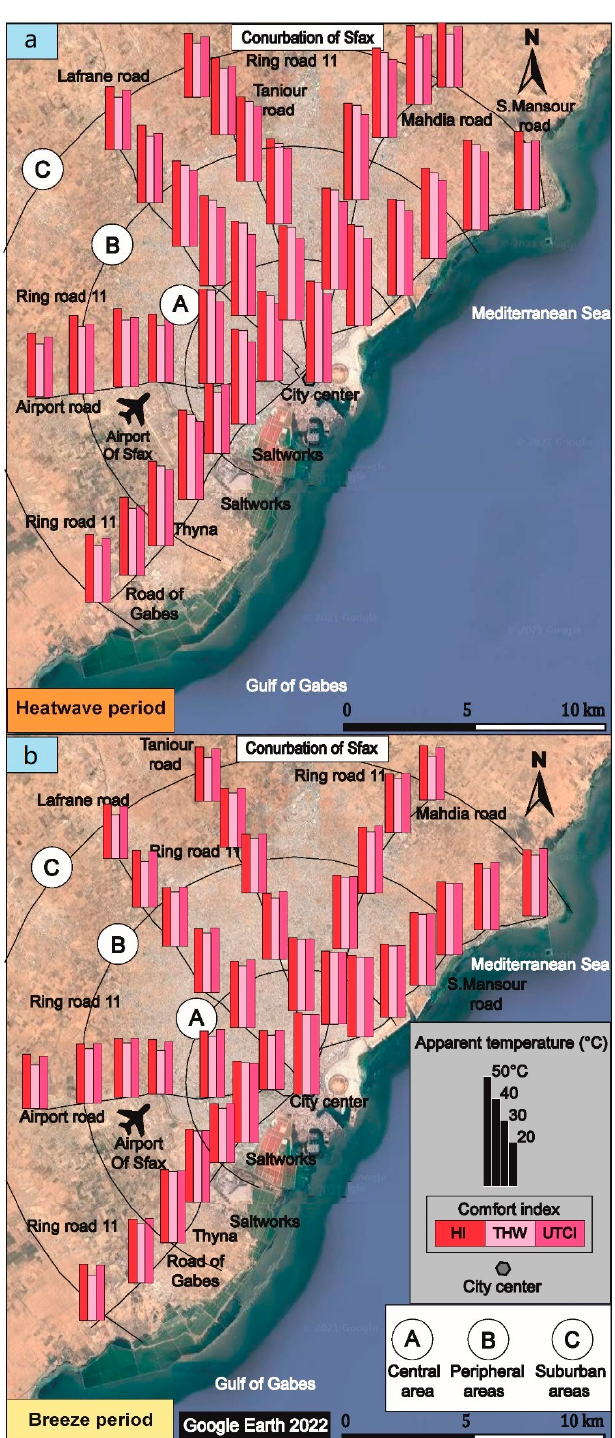
Figure 4. Spatial distribution of the risk of discomfort (mean of HI, UTCI and THW indices) during the hot season in the different areas of the Sfax conurbation based on 14 mobile thermo-hygrometry car surveys, ( a ) during breezy weather; ( b ) during the heatwave period at midnight during the summers of 2019 and